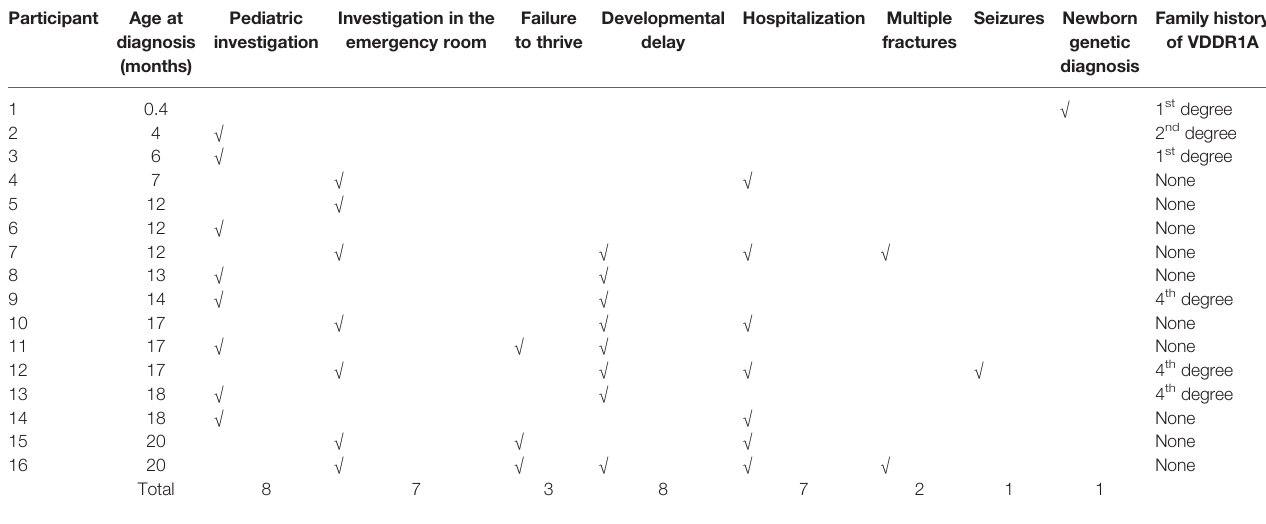
TABLE 5 | Clinical manifestations and medical history at